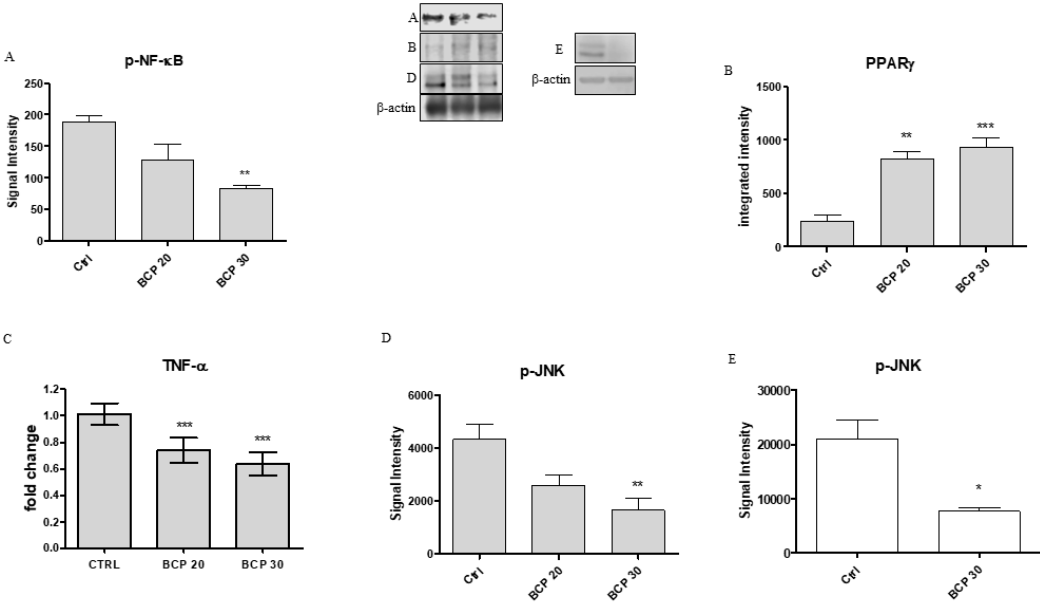
Figure 4. The graphs represent the protein expression of pNF- κ B ( A ), PPAR γ ( B ), pJNK ( D and E ) and mRNA expression of TNF- α ( C ) from U373 cells untreated and treated with BCP at the doses of 20 and 30 μ g/mL and U87 cells ( E ) untreated and treated with BCP at the dose of 30 μ g/mL. After the densitometric analysis, the data are expressed as signal intensity and as means ± SD. * p < 0.05, ** p < 0.01, *** p < 0.001, vs. the control.